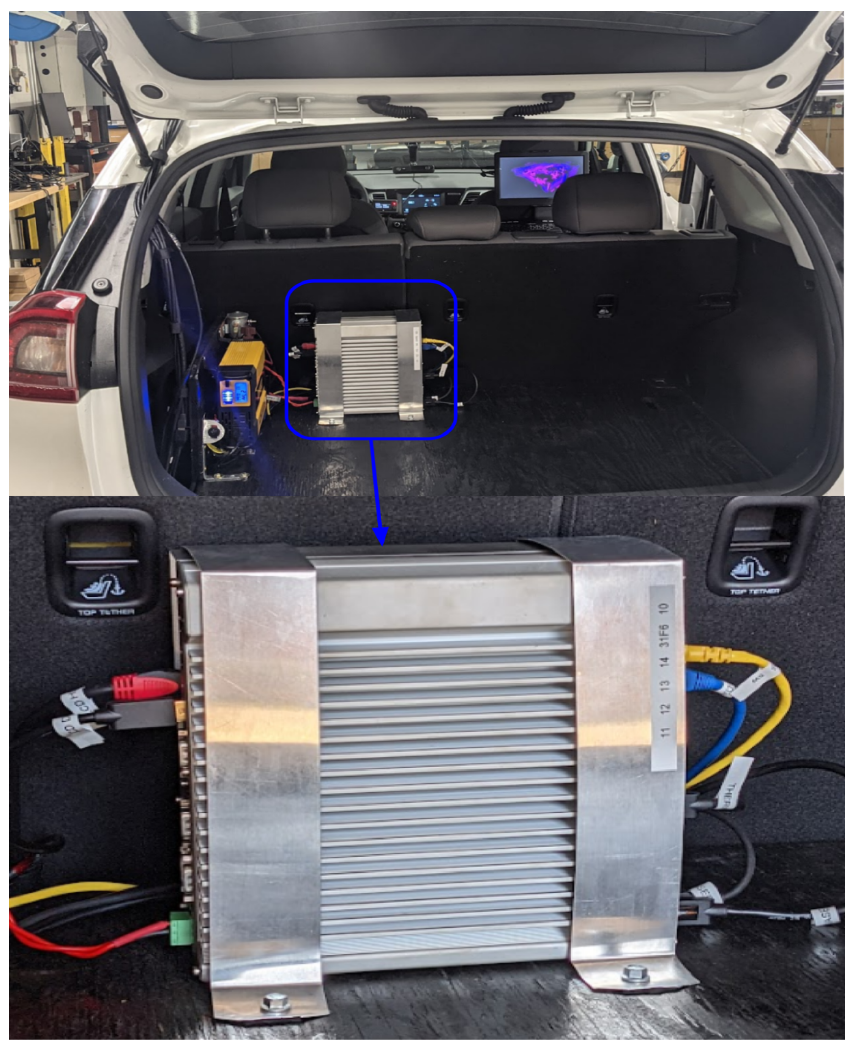
Figure 10. Nuvo PC—Ruggedized GPU-Computing Platform Supporting 120 W Nvidia ® GTX 1660Ti GPU and Intel ® 8th-Gen Core™ Processor, including i7-8700 pre-installed with Linux 18.04. Mounted in the rear of the